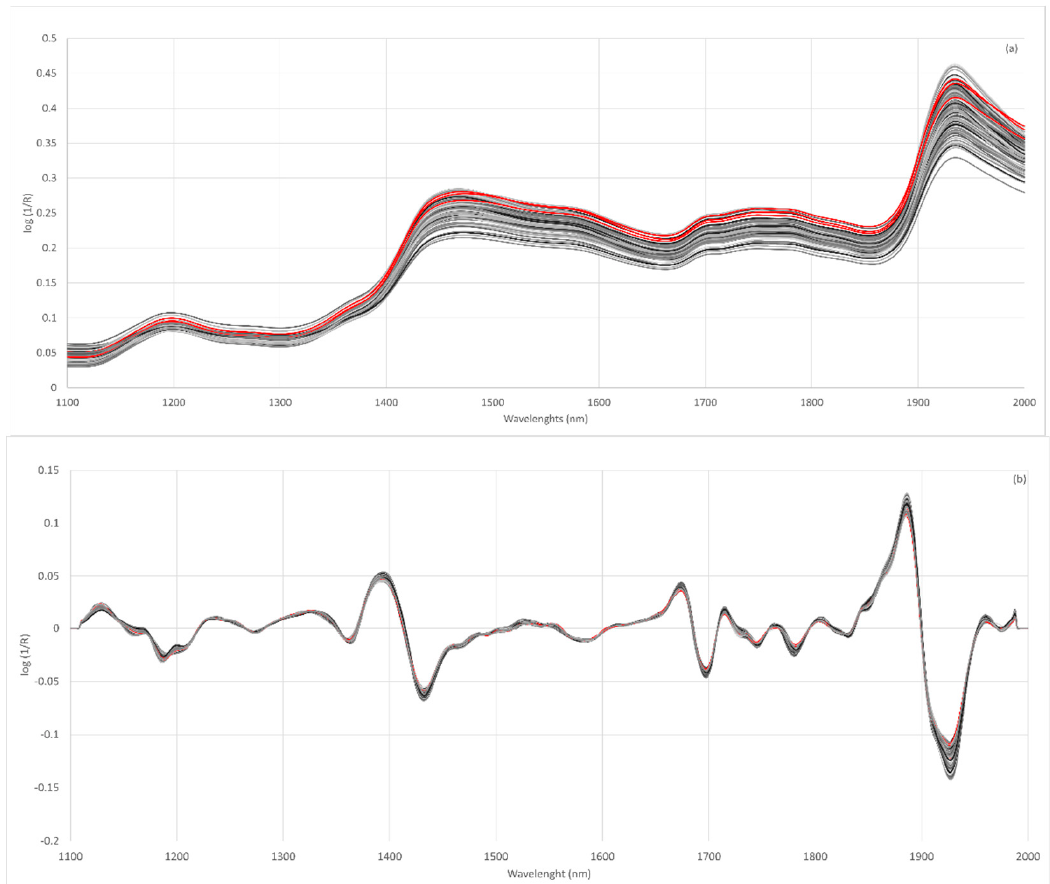
Figure 2. Raw NIR spectra of all flour samples analyzed ( a ), spectra after second derivative SNV 2,4,4,1 ( b ); wheat flours (red line), lentil flours (dark grey line) and fortified flours (light grey).